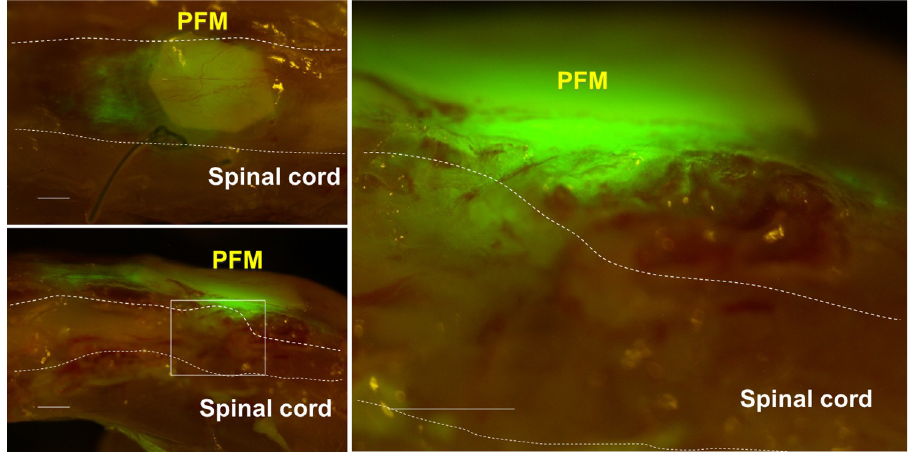
Fig 3. Expansion of implanted HAP stem cells in the severed spinal cord. GFP-expressing HAP stem cells migrated out from the PFM and joined the severed thoracic spinal cord. Left panel = low-magnification of coronal section (upper) and sagittal section (lower). Right panel = high-magnification of white boxed area. Bar = 500 μ